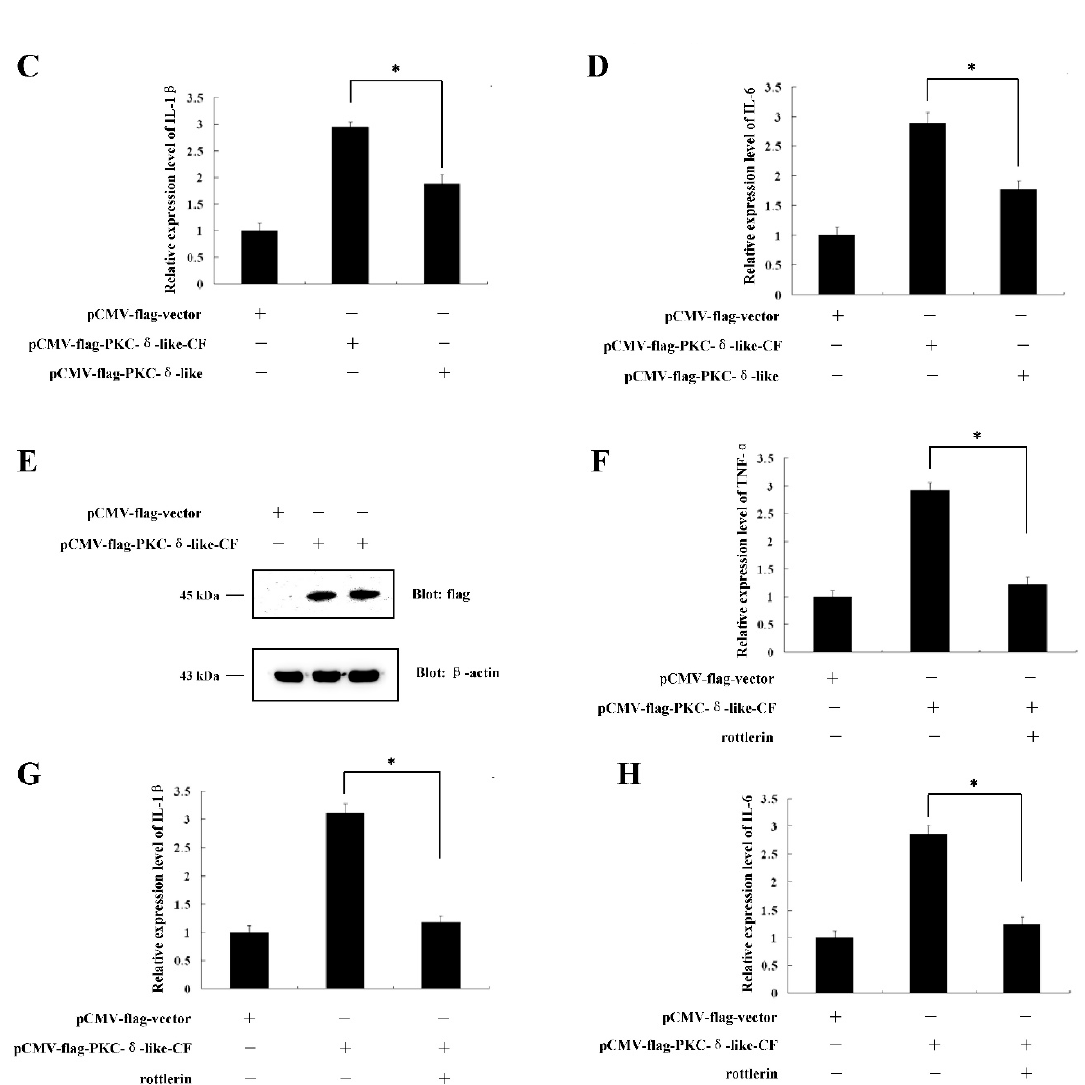
Figure 3. The e ff ect of over-expression of PKC- δ -like-CF on the cellular inflammation reaction. ( A ) The protein expression of PKC- δ -like-CF and PKC- δ -like in the RAW264.7 cells was detected. ( B ) The mRNA levels of TNF- α in the RAW264.7 cells, which were transfected with PKC- δ -like-CF or PKC- δ -like, were detected. ( C ) The mRNA levels of IL-1 β in the RAW264.7 cells, which were transfected with PKC- δ -like-CF or PKC- δ -like, were detected. ( D ) The mRNA levels of IL-6 in the RAW264.7 cells, which were transfected with PKC- δ -like-CF or PKC- δ -like, were detected. ( E ) The protein expression of PKC- δ -like-CF in the RAW264.7 cells was detected. ( F ) The mRNA levels of TNF- α in the PKC- δ -like-CF-transfected RAW264.7 cells, which were treated with or without rottlerin, were detected. ( G ) The mRNA levels of IL-1 β in the PKC- δ -like-CF-transfected RAW264.7 cells, which were treated with or without rottlerin, were detected. ( H ) The mRNA levels of IL-6 in the PKC- δ -like-CF-transfected RAW264.7 cells, which were treated with or without rottlerin, were detected. The asterisk indicates p <